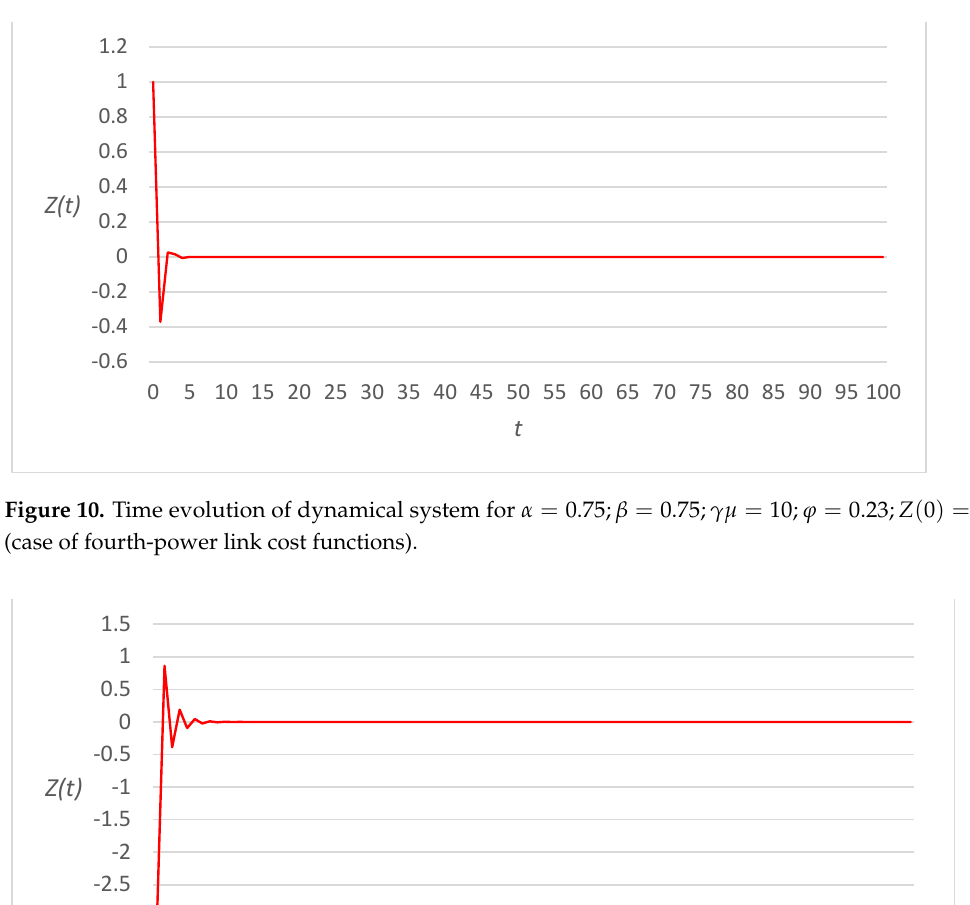
Figure 9. Time evolution of dynamical system for α = 0.1; β = 0.1; γµ = 2.5; ϕ = 0.6; Z ( 0 ) = 5 (case of fourth-power link cost functions).